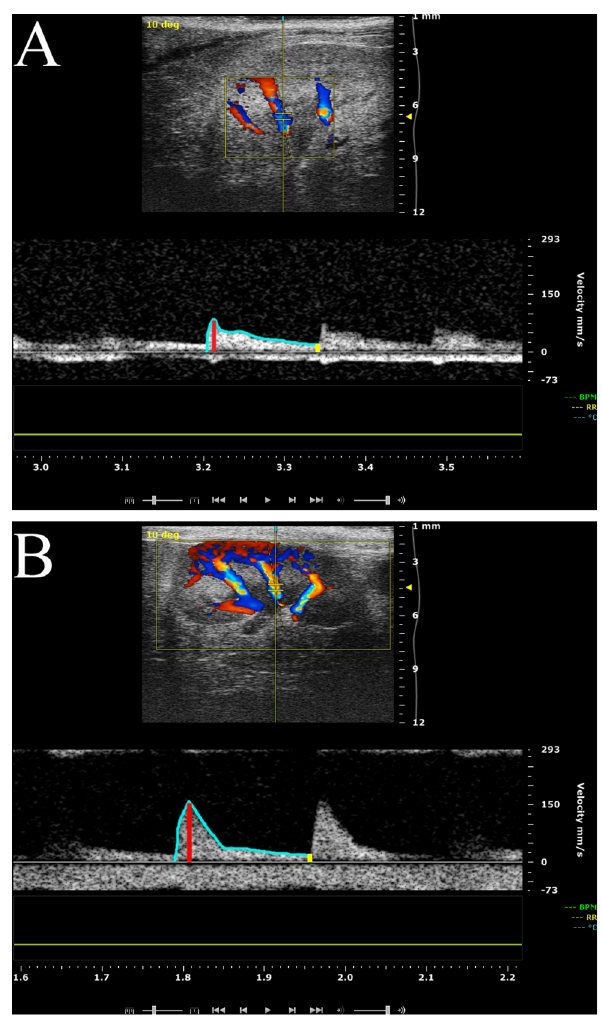
Fig 2. Representative color Doppler image for measurement of renal flow velocities. Typical recordings of intrarenal flow velocities measurement in segmental renal arteries were performed with color Doppler ultrasound in lean and leptin-deficient (ob/ob) mice at 21 weeks of age. The pulsatility flow profile was used for measurement of peak systolic velocity (PSV) (red line), mean velocity (MV) (blue line) and lowest diastolic velocity (LDV) (yellow line) for calculation of pulsatility index and resistive index. A: Renal flow velocity profile in lean mice. B: Renal flow velocity profile in ob/ob